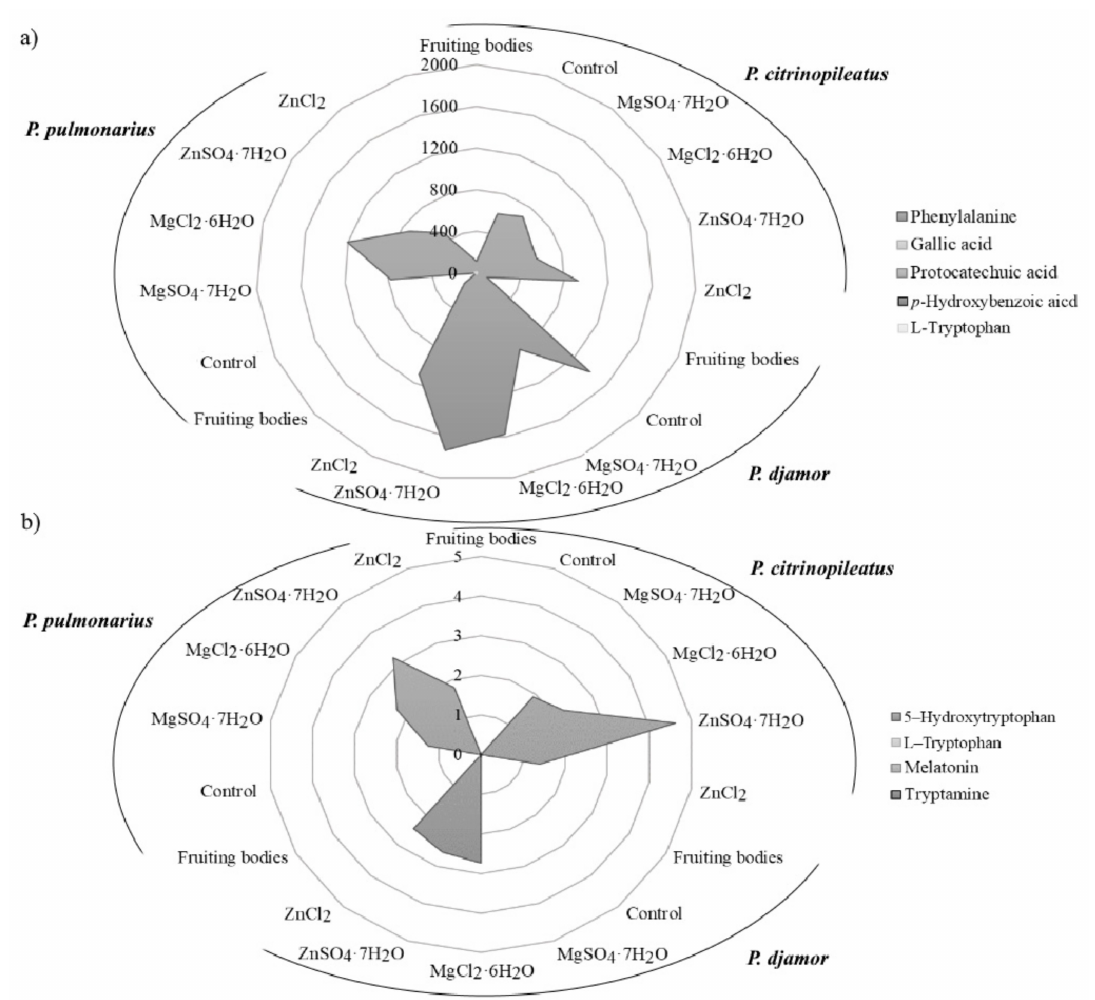
Figure 3. The content of organic compounds: ( a ) phenols and ( b ) indoles (mg/100 g d.w.) in the fruiting bodies of Pleurotus citrinopileatus , Pleurotus djamor , and Pleurotus pulmonarius , from in vitro cultures (control), and in vitro cultures enriched with zinc (ZnSO 4 · 7H 2 O and ZnCl 2 ) and magnesium (MgSO 4 · 7H 2 O and MgCl 2 · 6H 2